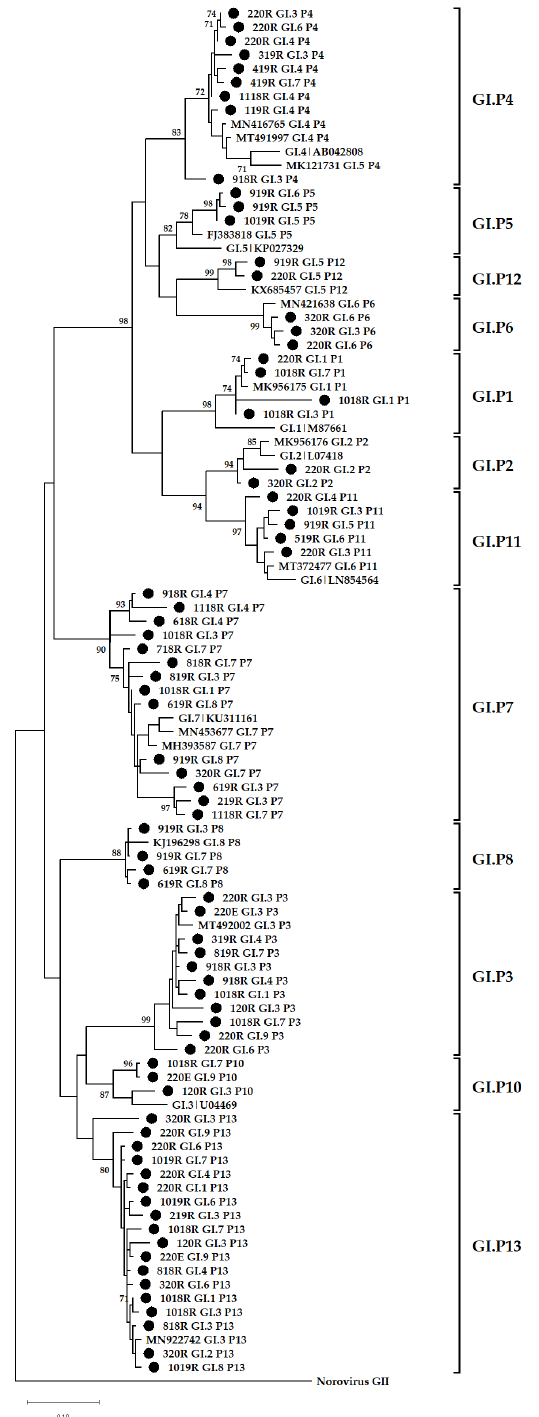
Figure 4. Phylogenetic analysis of the 265 bp at 3 (cid:48) -end of norovirus GI ORF1. Representative sequences identified in this study are indicated by black circles ( • ). All strain sequence names contain specific ID, genotype and P-type. Reference strains and the most closely related strains were downloaded from GenBank. The Maximum Likelihood phylogenetic trees were constructed using MEGA X software [46] and 1000 bootstrap replicates based on the Kimura 2-parameter model. The sequences were labelled according to month and year of detection, wastewater type, P-type and genotype, e.g., 618RGI.2[P2] = GI.2[P2] virus detected in raw sewage collected in June